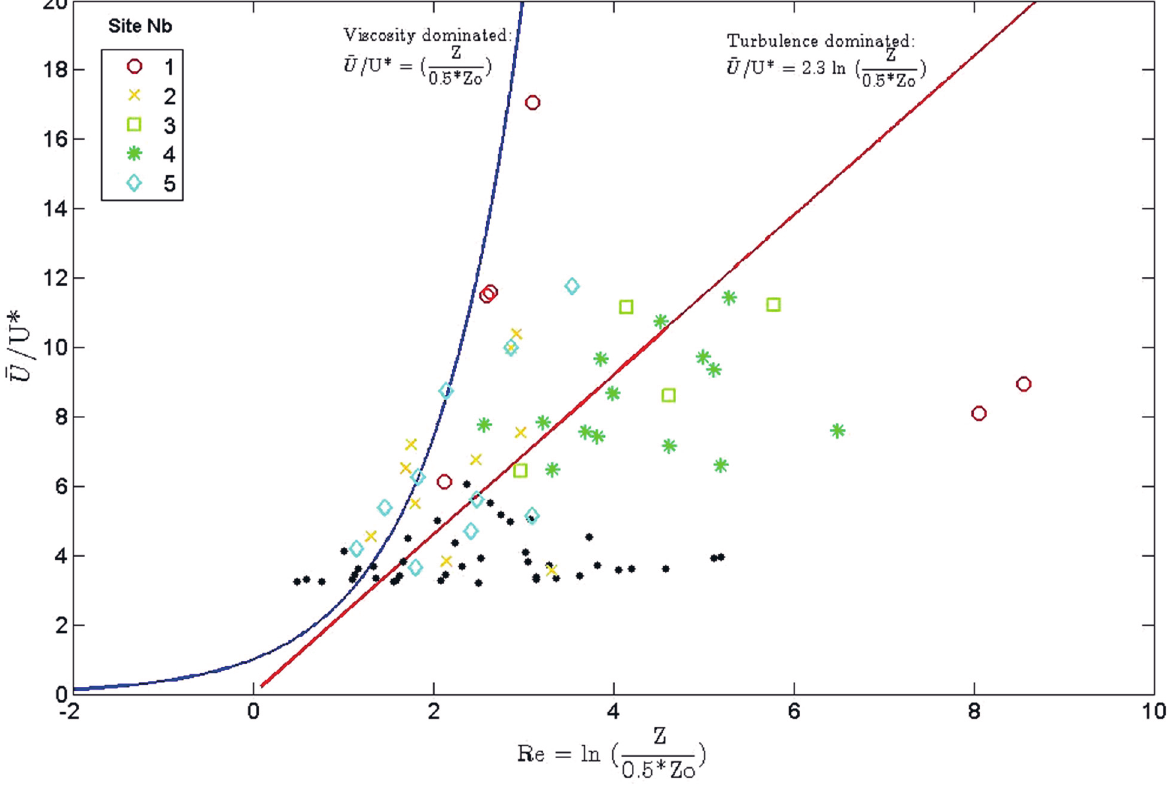
Figure 11. Fits of the data at sites 1 to 5 to the concepts of boundary layer flow under laminar (blue line) and turbulent (red line) flows on the Clauser plot. Black dots represent data from sites 8 to 10, characterized by the presence of